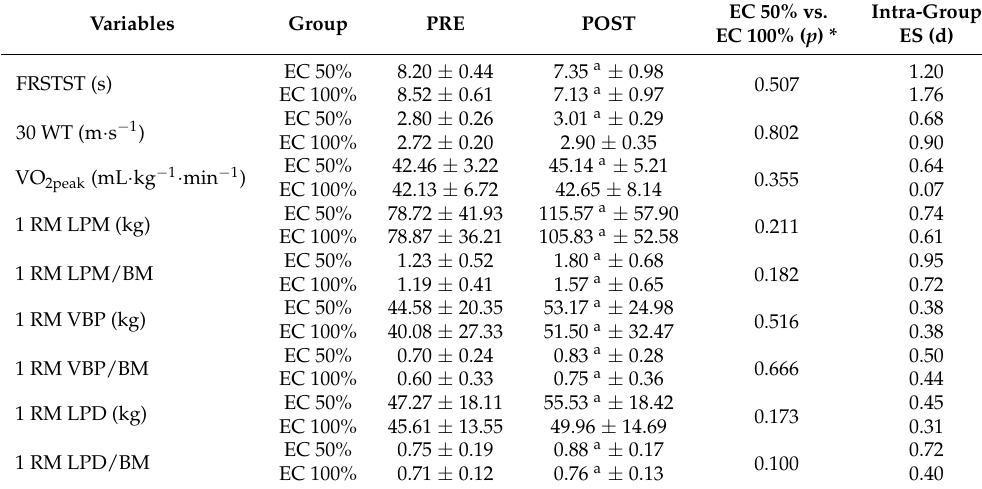
Table 4. Results of peak oxygen uptake, muscle strength, and functional mobility.